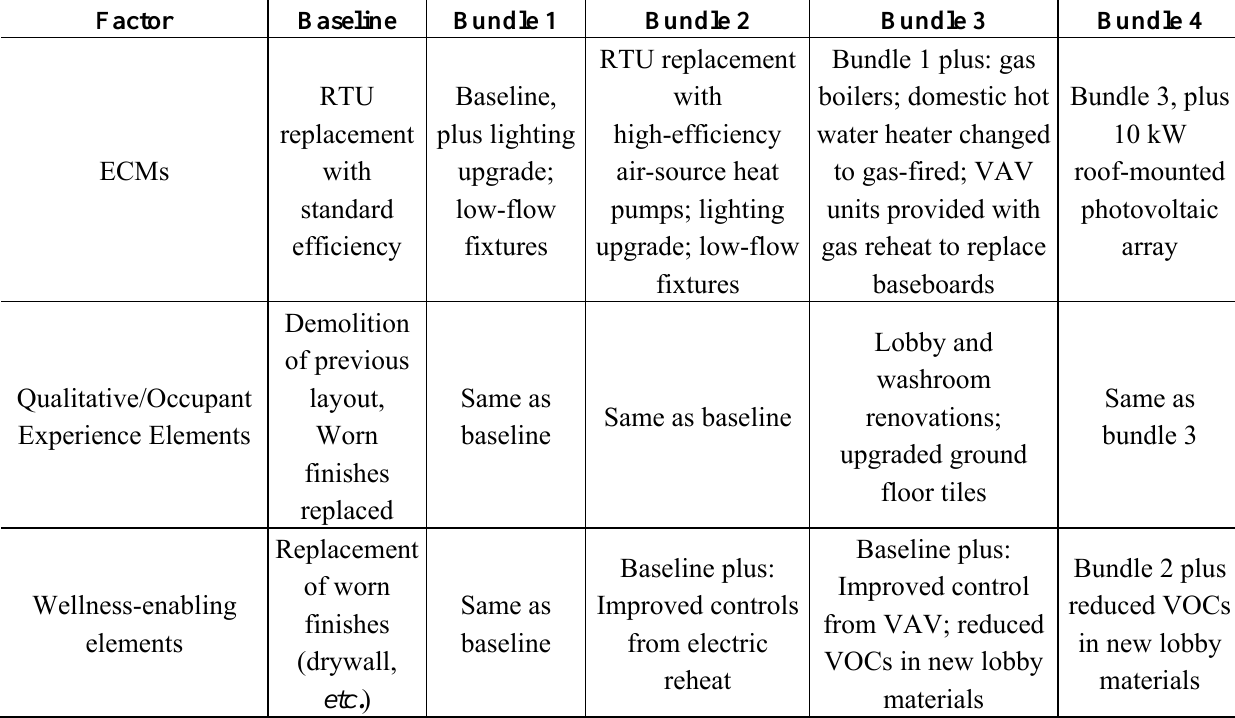
Table 4. Summary of renovation